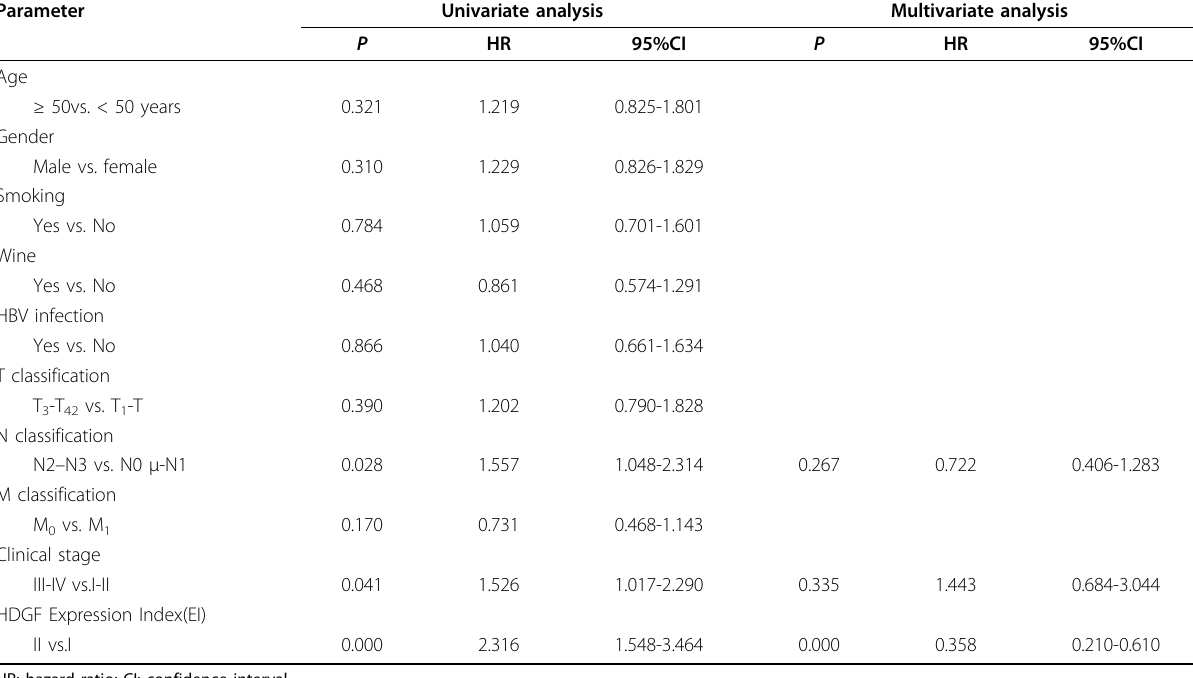
Table 2 Summary of univariate and multivariate Cox regression analysis of overall survival duration